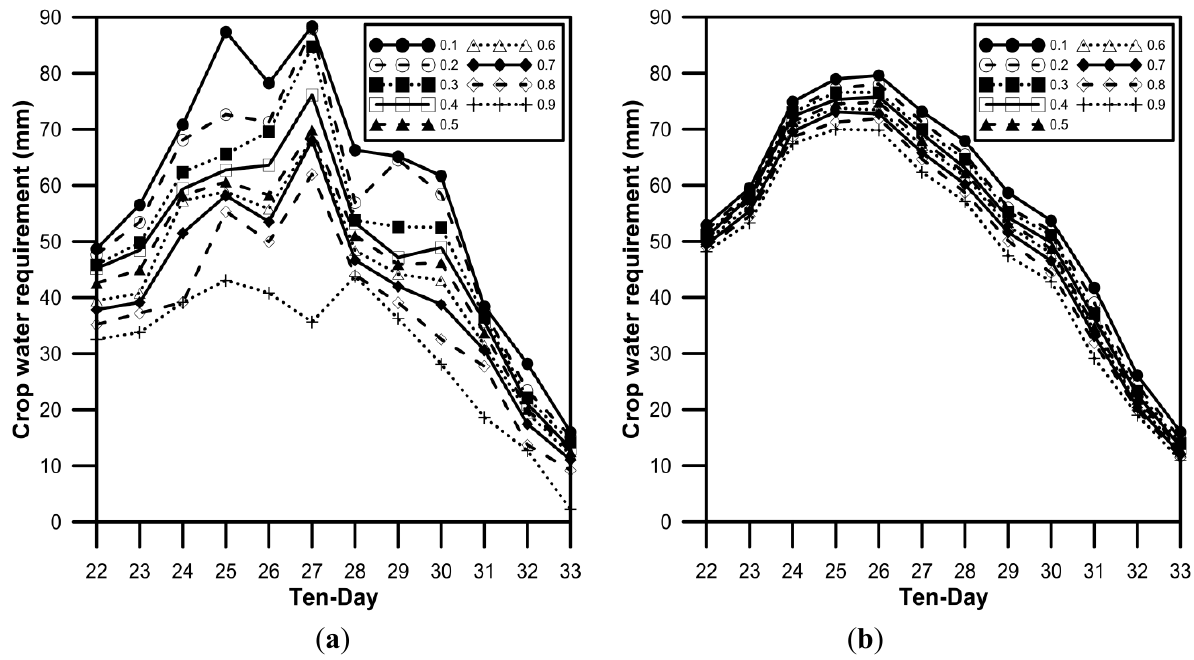
Figure 12. Exceedance probability distribution of crop water requirement at each ten-day during the second cropping season. ( a ) present (2004–2011); ( b ) future (2046–2065).